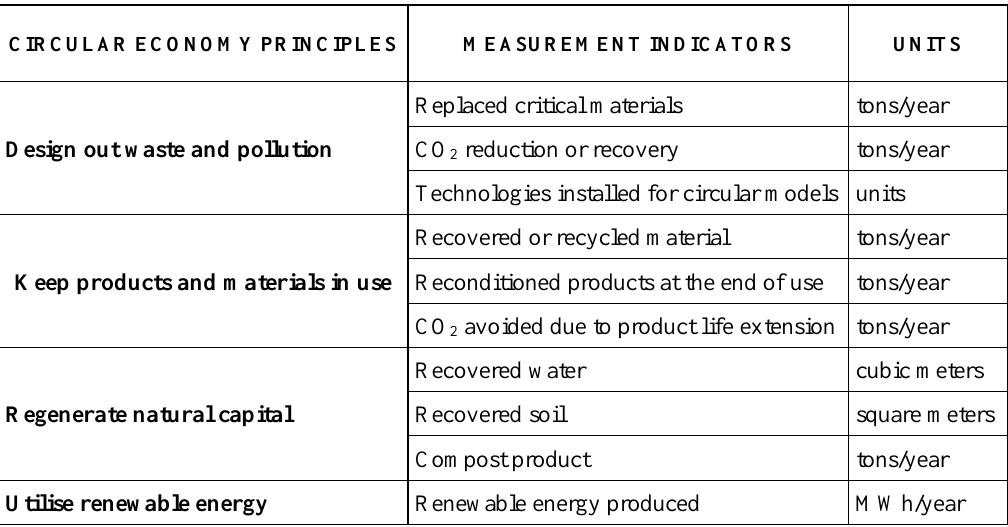
Table 2: Measurement Indicators CIRCULAR ECONOMY